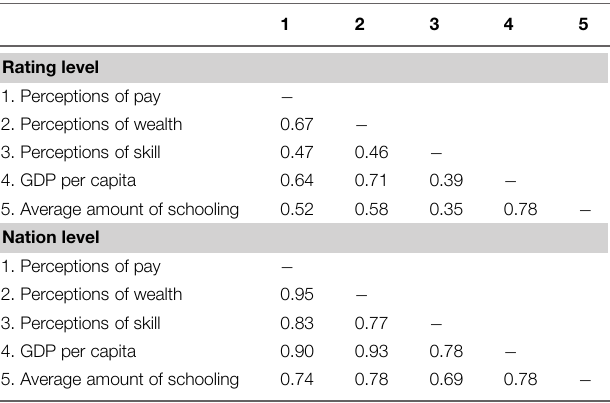
TABLE 2 | Correlations among rated and actual nation characteristics by level of aggregation. 1 2